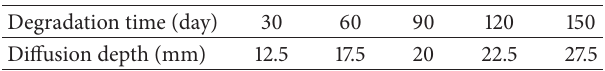
Table 4: Sulfate diffusion depth in concrete at various degradation times.